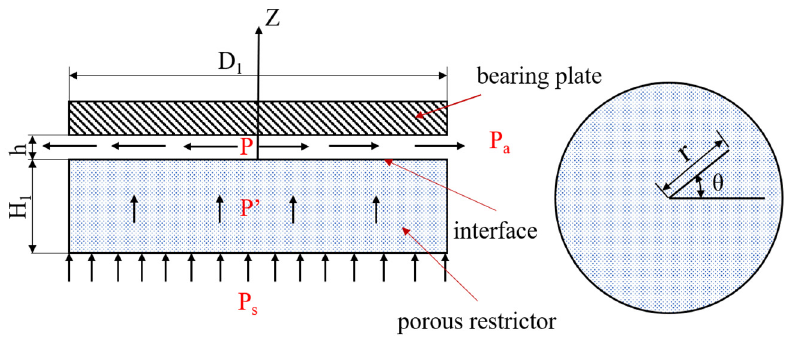
Figure 4. The schematic structure of the aerostatic bearing.